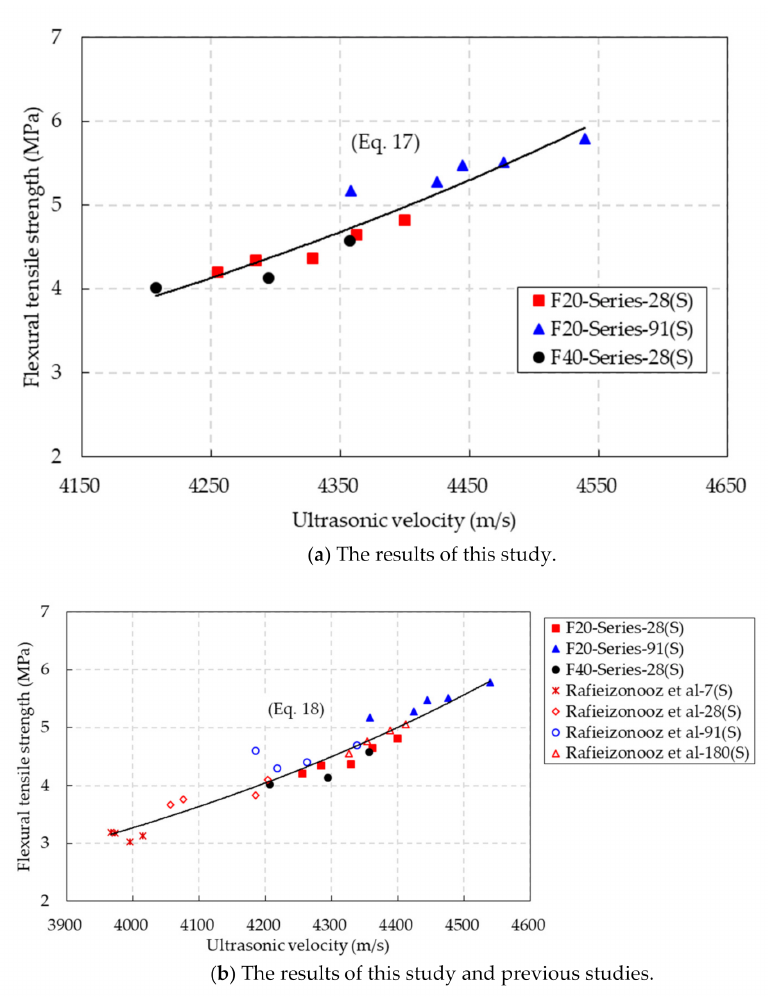
Figure 17. Relationship between the ultrasonic velocity and flexural tensile strength under SSD